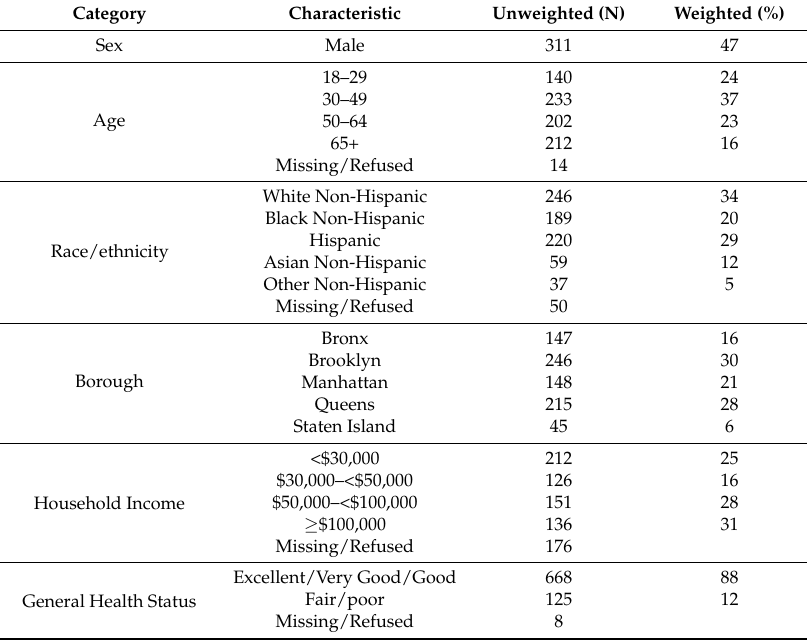
Table 1. Characteristics of survey respondents ( n = 801), New York City,